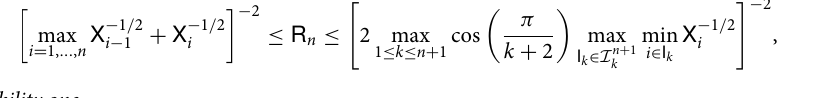
, R n converges to 1/8 with probability → ∞